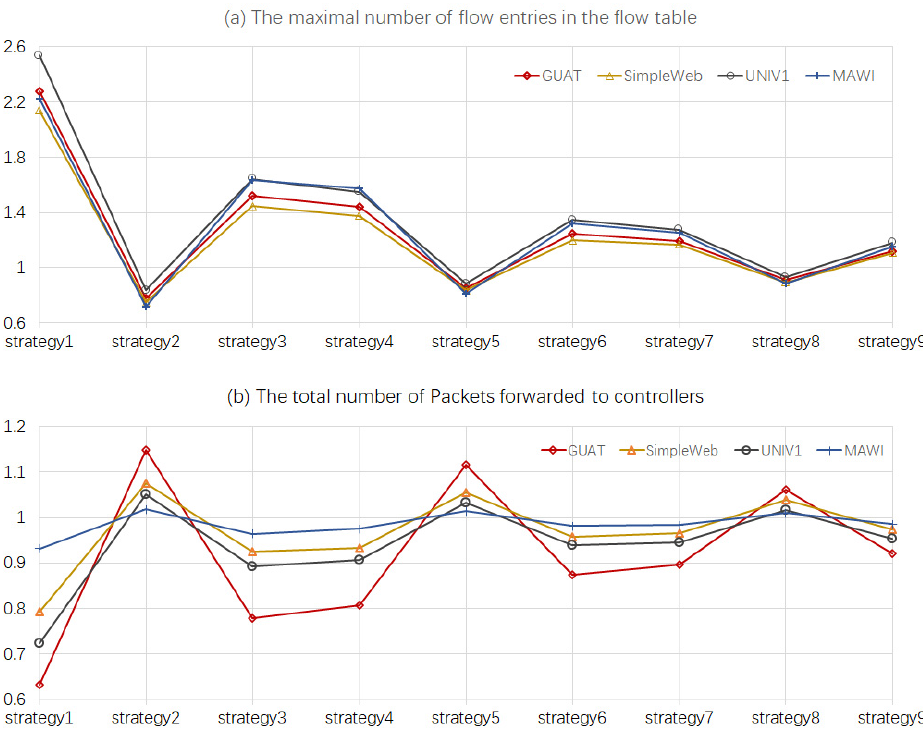
Figure 6. Applying a staircase randomized response with no flow-table constraints and LDoS attacks. It was apparent that the network performed differently under different